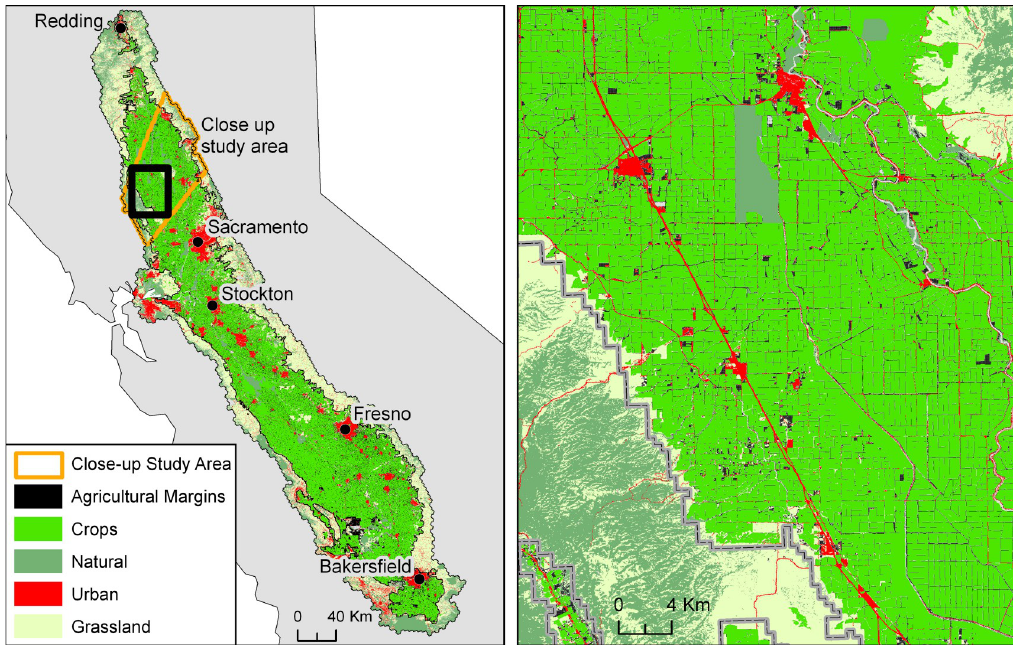
more clearly as linear features in close-up map (right panel). There is a black line around the total study area (Central Valley and adjoining lands; see text for details) as well as the predominantly agricultural inner study area, which is also shown with the gray line in the right panel. The darker green areas are conservation lands that are treated as natural in our